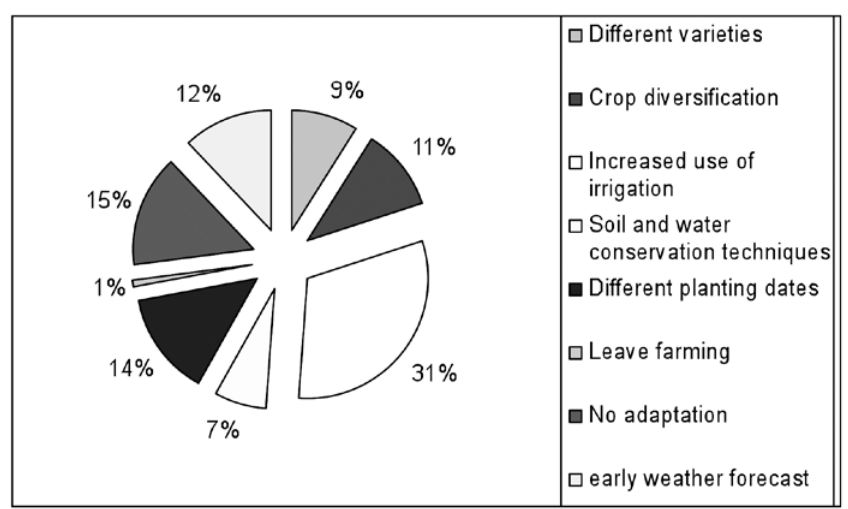
Fig 6. Farmers’ preferred adaptation to climate change